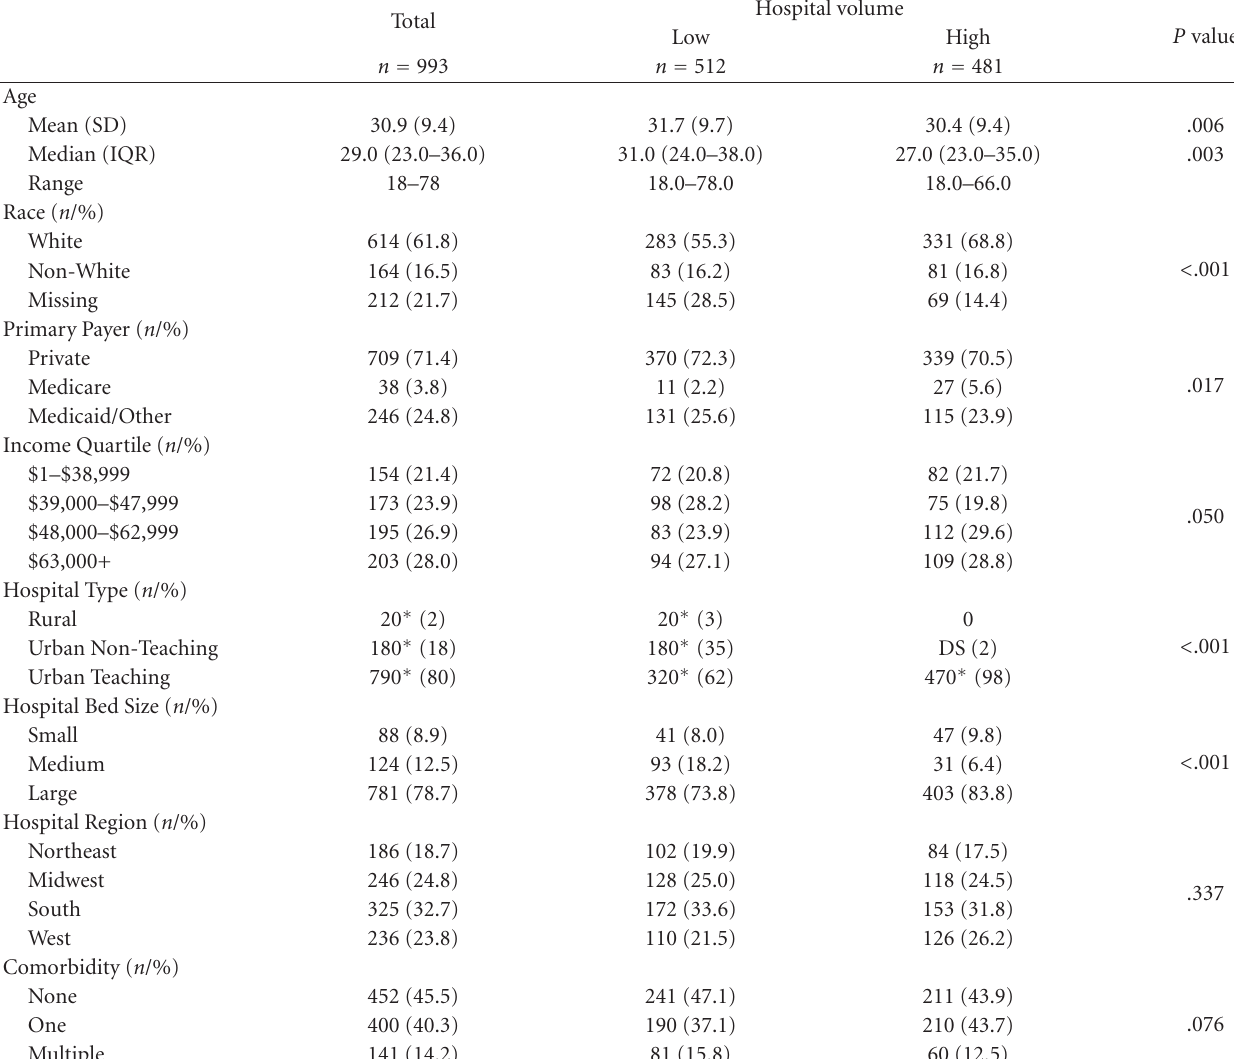
Table 1: Characteristics of the RPLND study